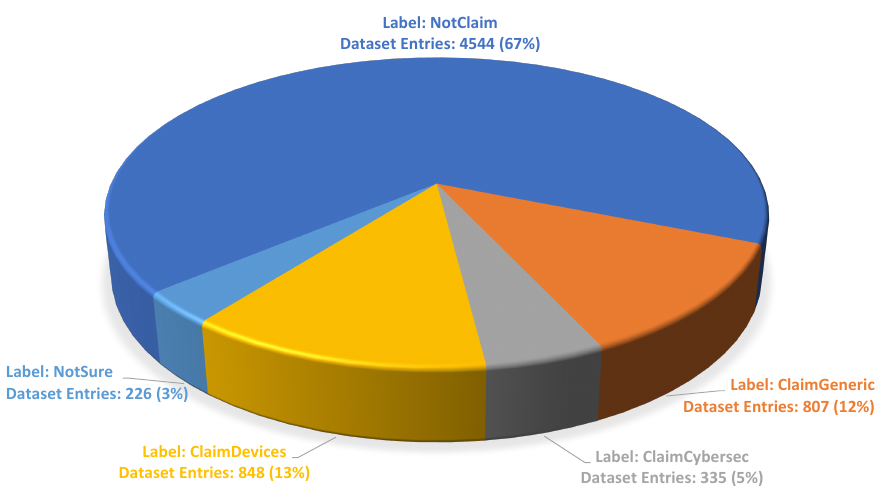
Figure 2. An illustration of the labeled dataset and classes used to train our classifiers.